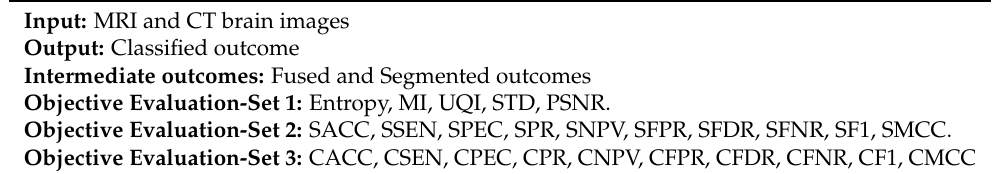
Table 1. Fusion of a proposed segmentation and classification system for brain